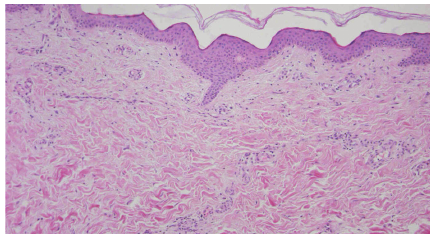
Figure 2: The cutaneous biopsy of flagellate erythema (magnifica- tion × 10) depicting atrophic epiderma. In the superficial derma, there was a slight inflammatory infiltrate, essentially composed of mononuclear cells and rare